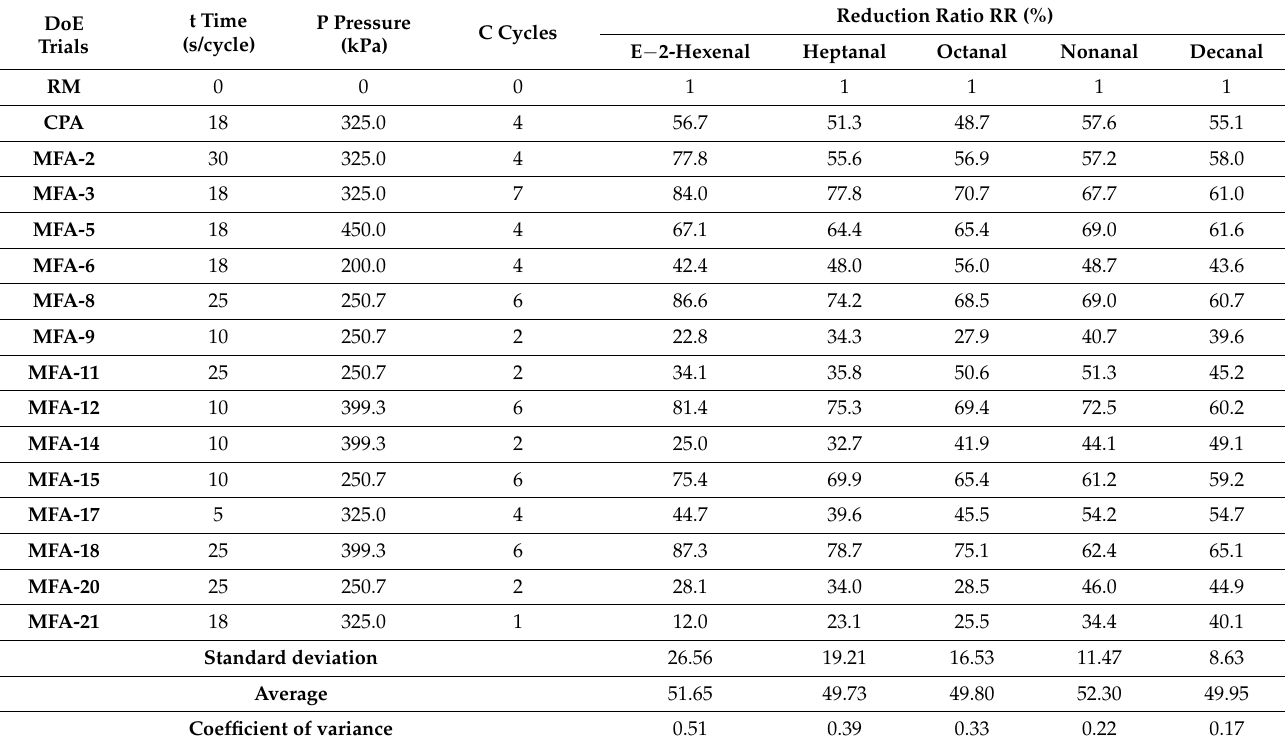
Table 3. DoE reduction rate (RR) of the main volatile molecules versus MFA treatment